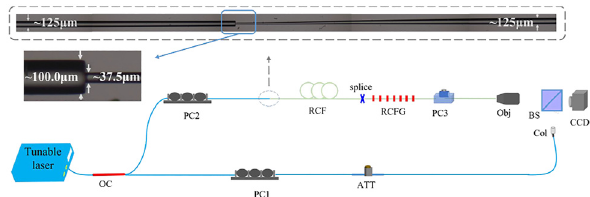
Figure 10: Experimental setup for the mode conversion and detection. OC, 1:1 optical coupler; PC, polarization controller; Obj, objective; ATT, attenuator; BS, beam splitter; Col, collimator; RCFG, RCF grating; CCD, charge-coupled device.